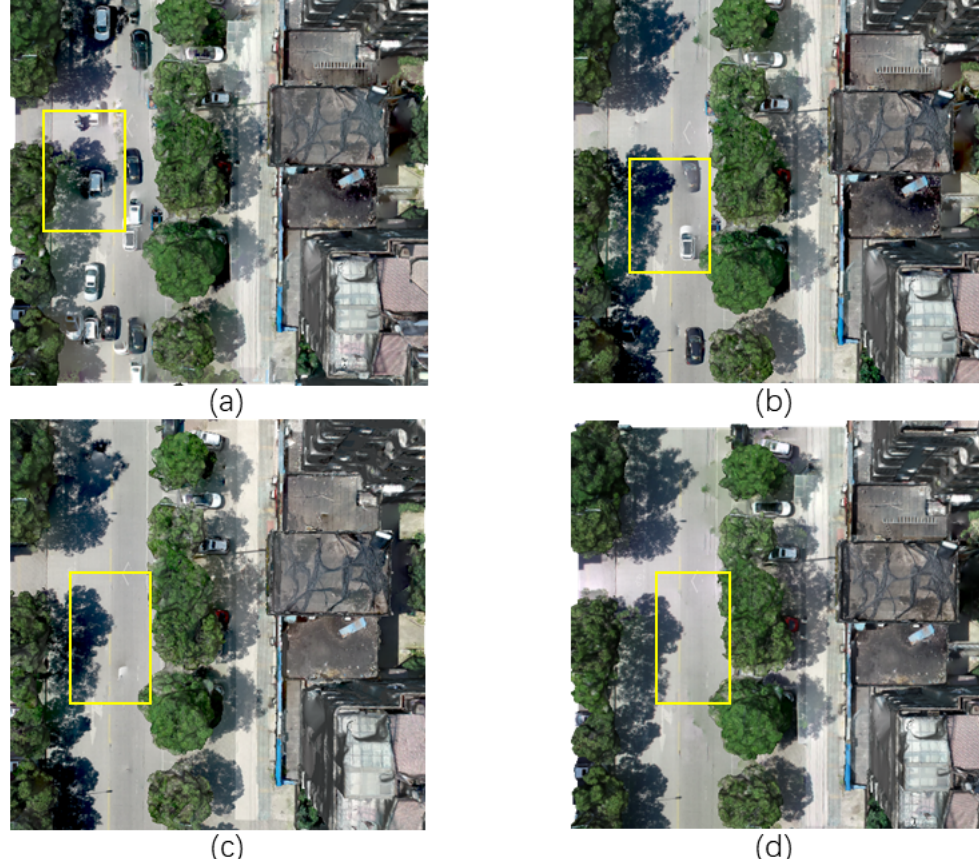
Figure 8. Comparison of texture-mapping results of the road wires of in dataset TJH-0078. ( a ) results of experiments without image consistency detection; ( b ) results of mvs texturing; ( c ) results of our method; ( d ) results of our method with semantic